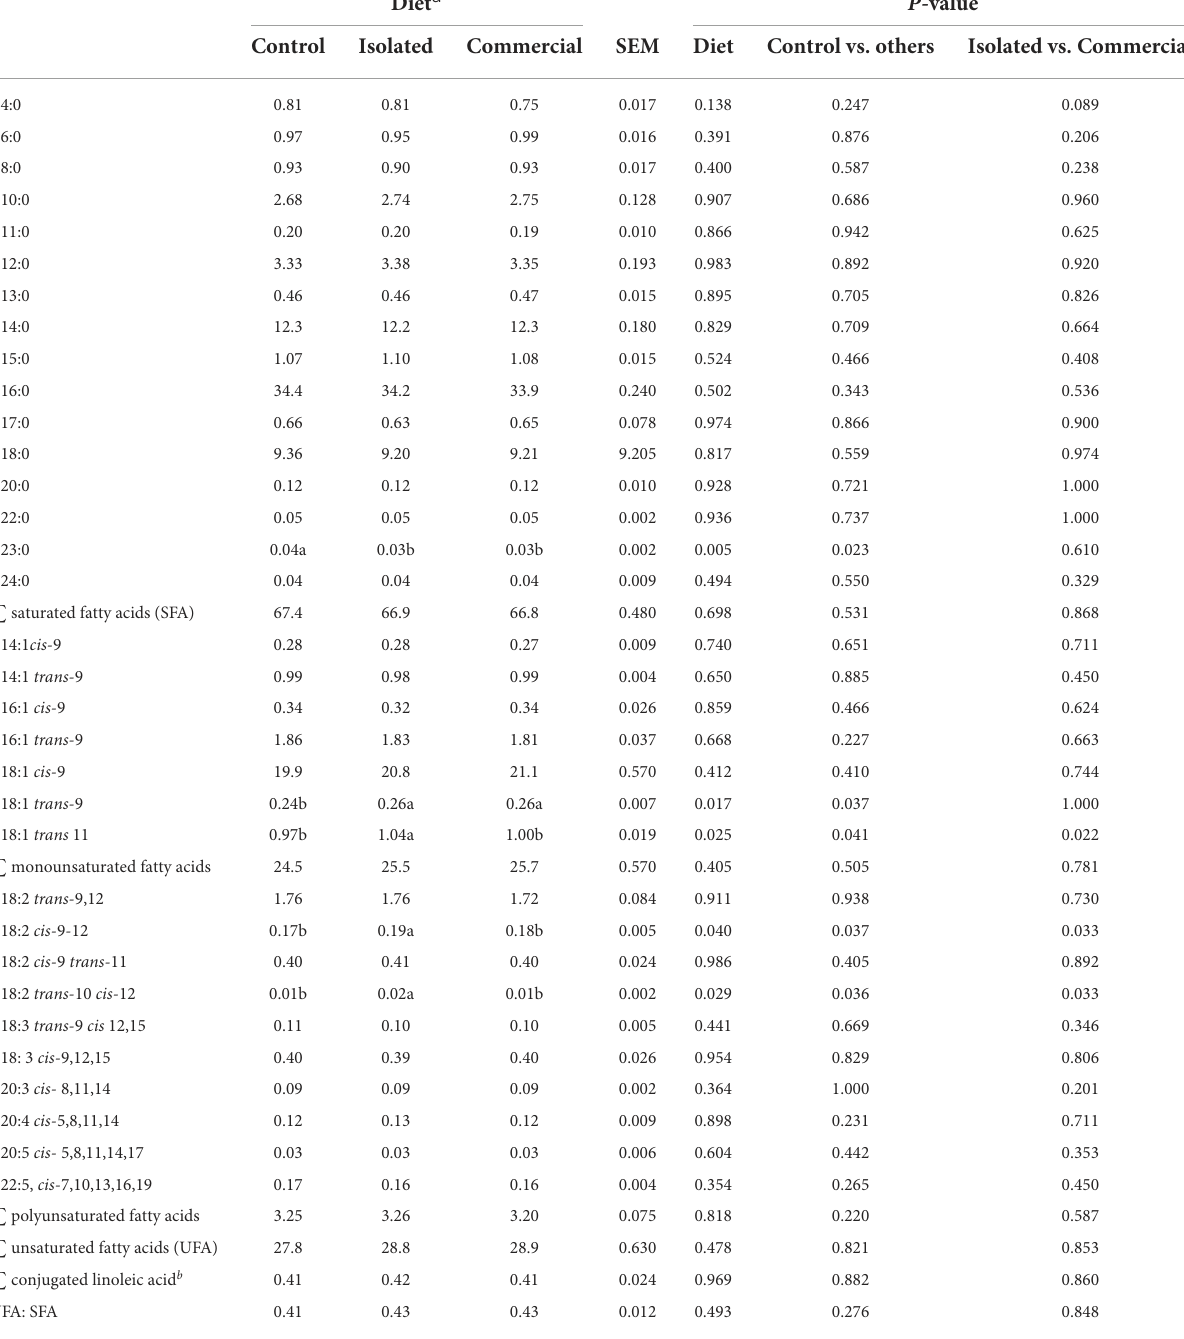
TABLE 6 Experiment 2: Milk fatty acid profile (g/100g fatty acids) of lactating Holstein cows fed diets supplemented with isolated or commercial E. faecium as probiotics. Diet a P -value Control Isolated Commercial SEM Diet Control vs. others Isolated vs.